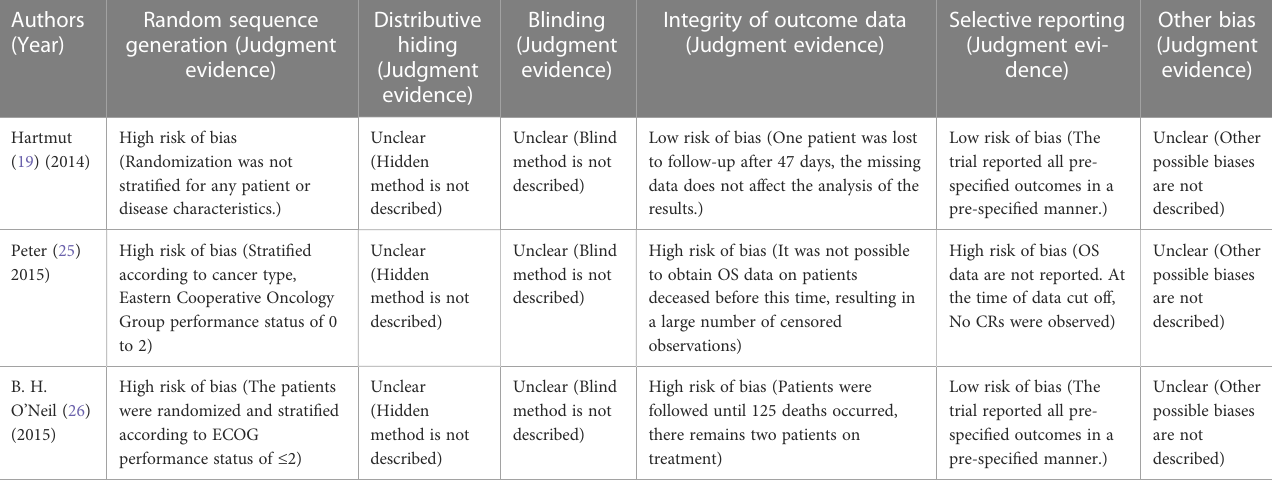
TABLE 3 The risk of bias of independent small